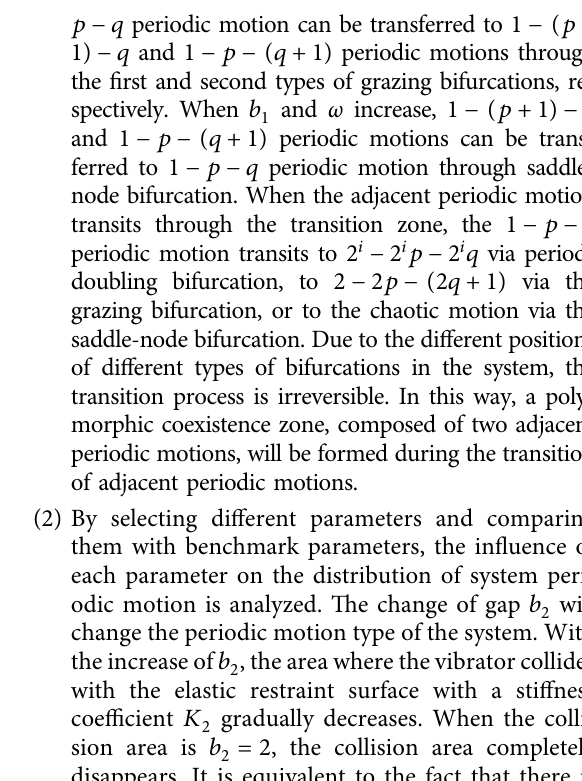
Figure 14: Distribution of periodic motion with ζ changes. (a) kc � 0 . 05. (b) kc � 0 . 3. (c) kc � 0 .